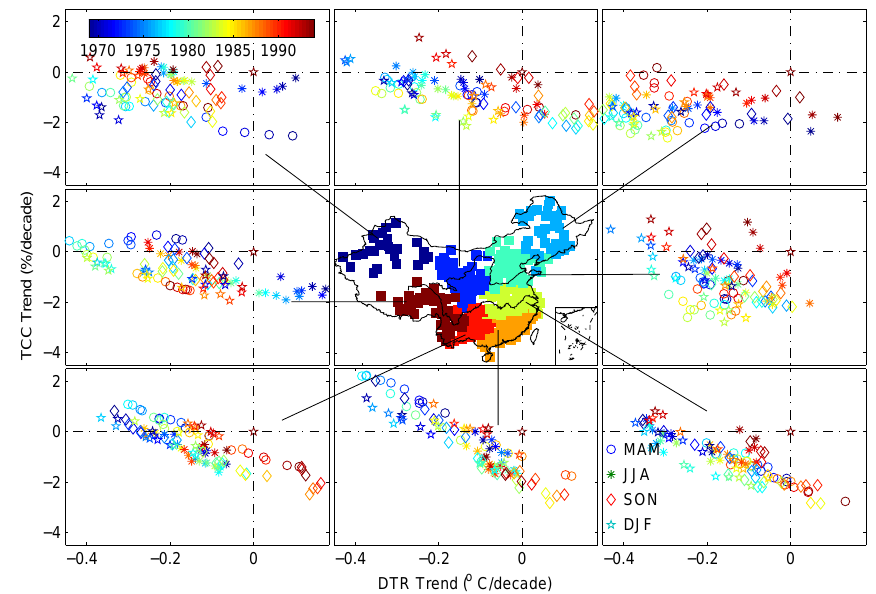
Fig. 5. Scatter-plot of trends of diurnal temperature range and total cloud cover based on 30-year windows of the time series.